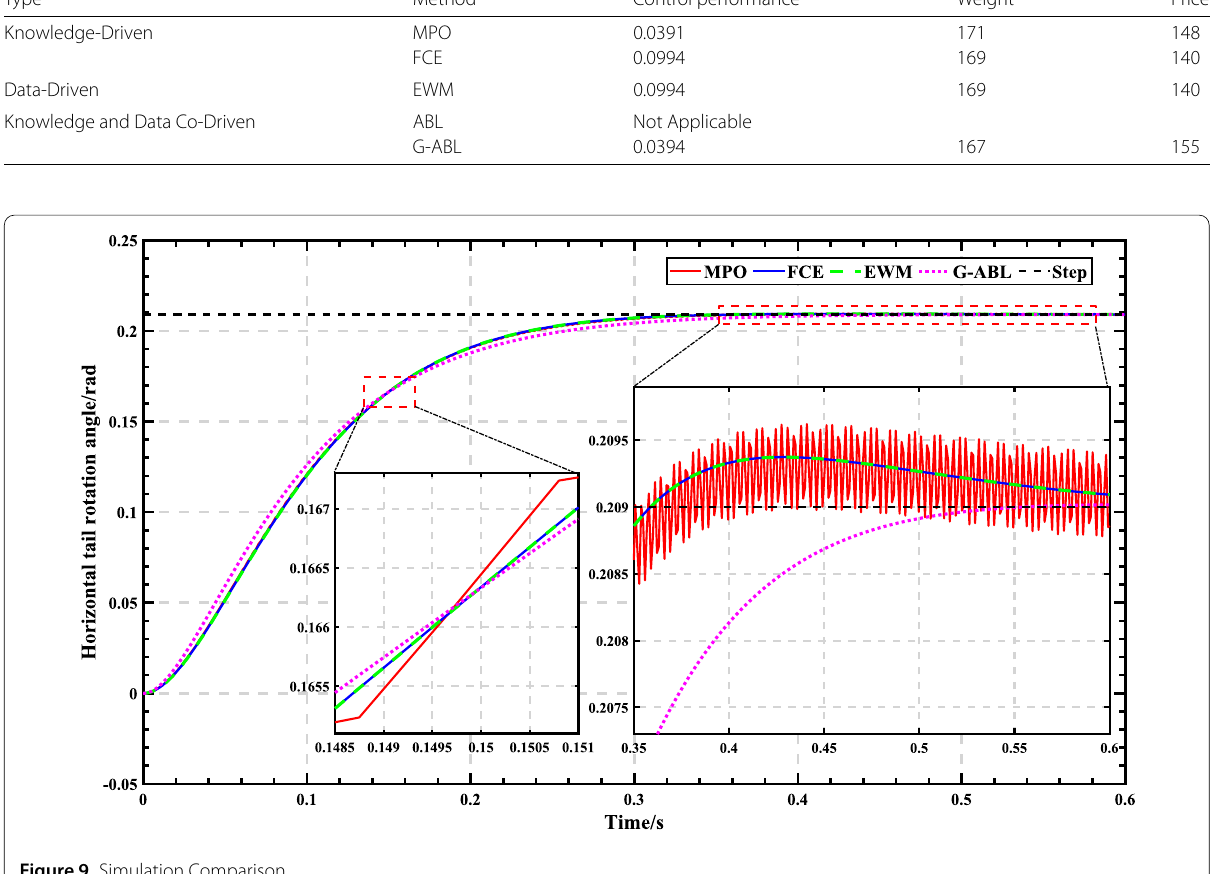
Figure 9 Simulation